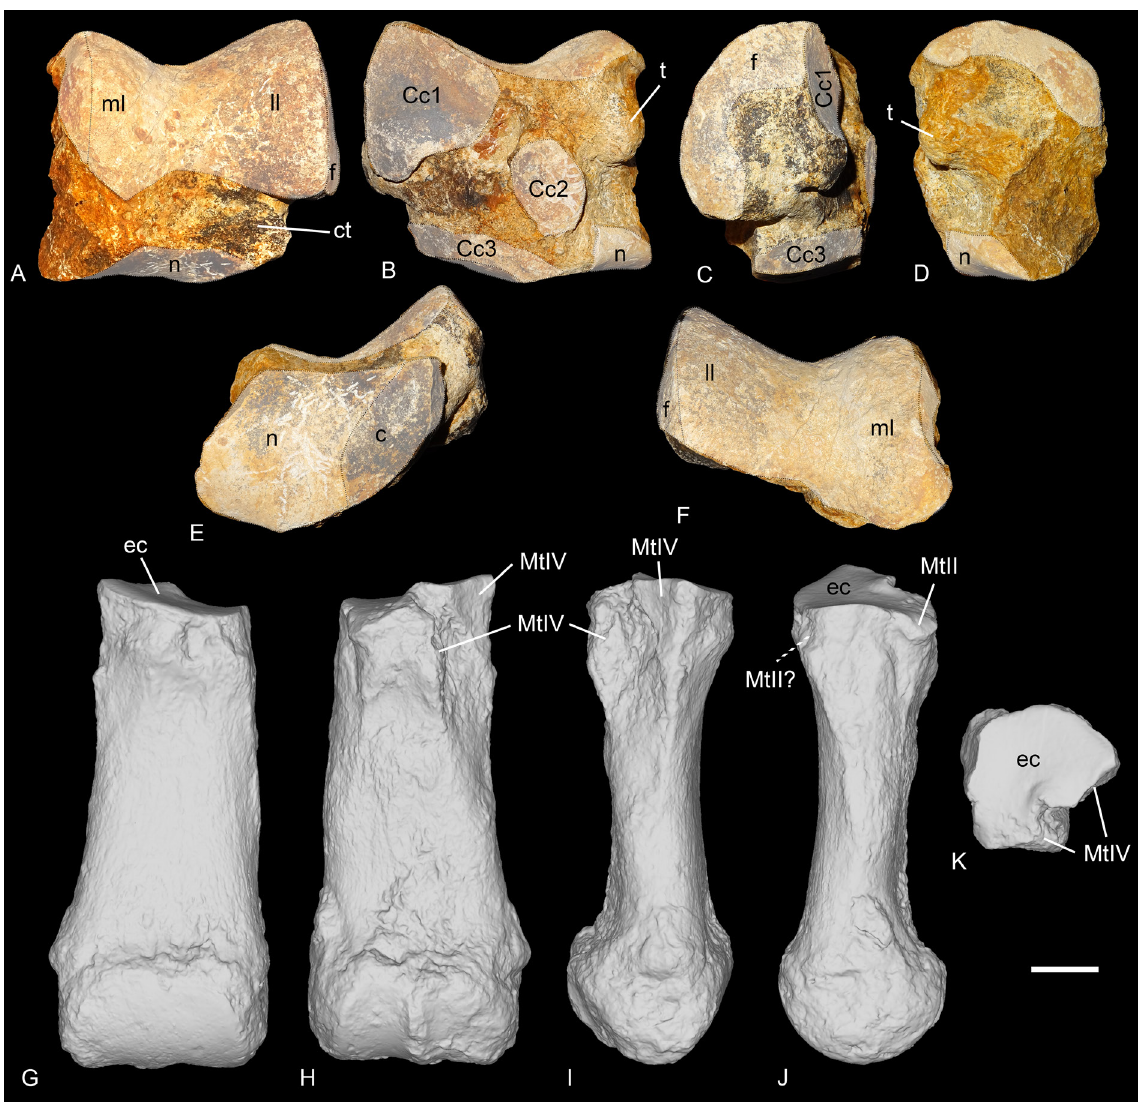
Fig. 20. Ronzotherium romani Kretzoi, 1940 from Gaimersheim (late Oligocene, Germany). – A–F . Left astragalus (BSPG collection). A . Anterior view. B . Posterior view. C . Lateral view. D . Medial view. E . Distal view. F . Proximal view. – G–K . Left MtIII BSPG-1952-II. G . Anterior view. H . Posterior view. I . Lateral view. J . Medial view. K . Proximal view. Abbreviations: c = cuboid; Cc1 = calcaneus facet 1; Cc2 = calcaneus facet 2; Cc3 = calcaneus facet 3; ct = collum tali; ec = ectocuneiform; f = fibula; ll = lateral lip; ml = medial lip; n = navicular; t = tuberosity. Scale bar: 2